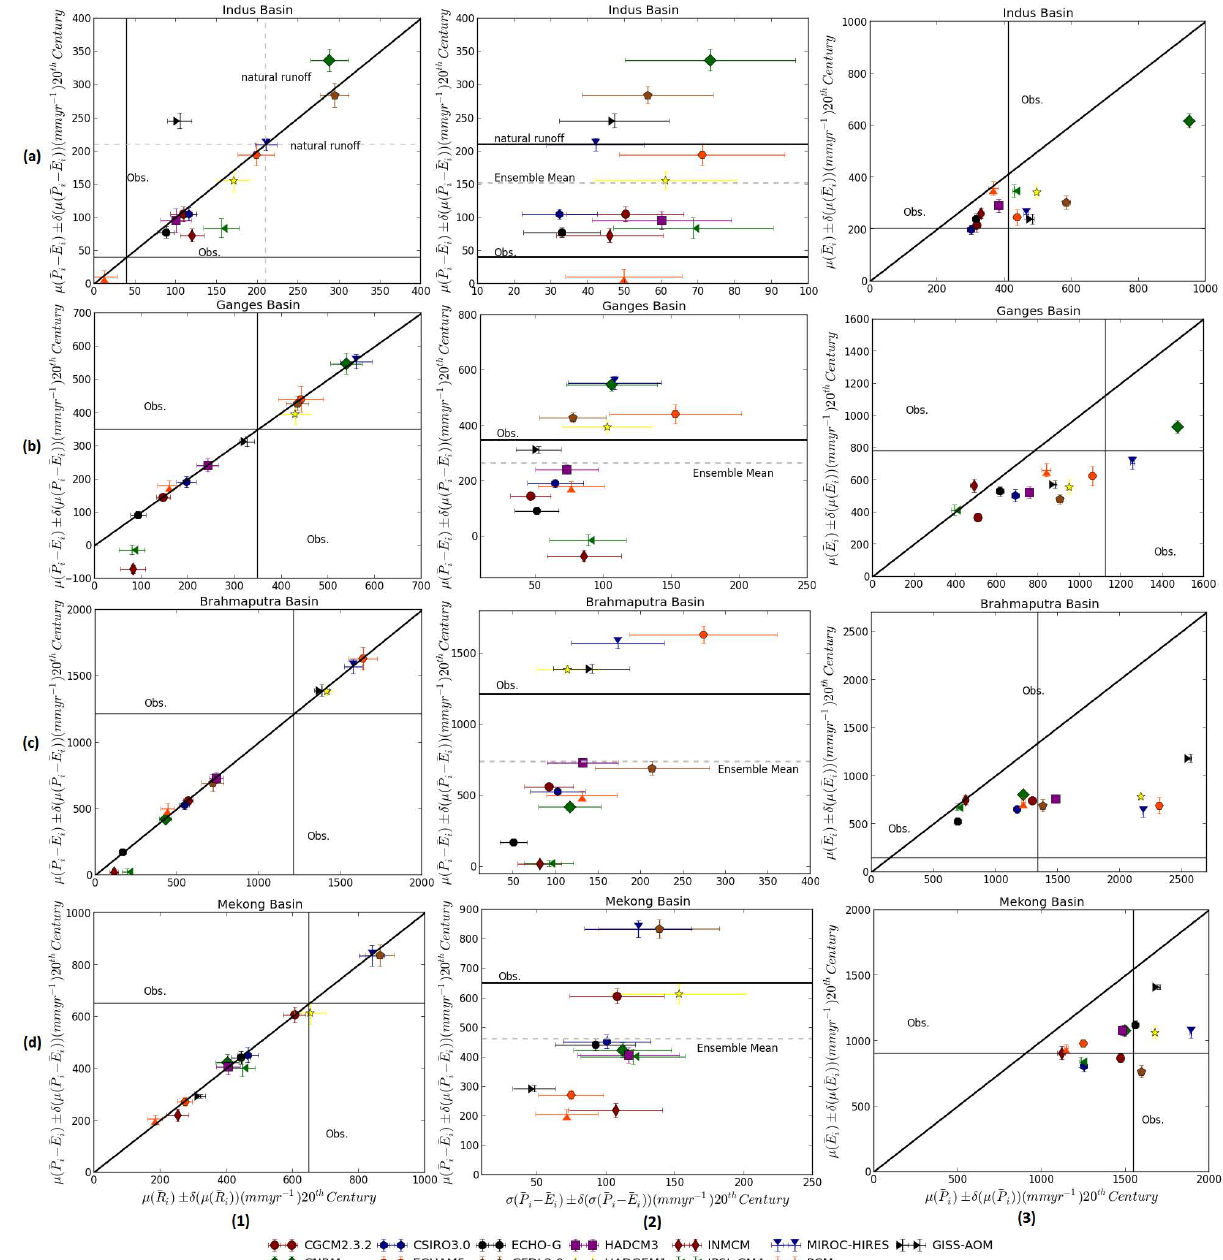
Fig. 2. (a1) – (d3) 20th century climate (1961–2000) for: (row a) Indus Basin, (row b) Ganges Basin, (row c) Brahmaputra Basin, (row d) Mekong Basin; (column 1) estimated P − E against simulated total runoff, (column 2) estimated P − E against its inter-annual variability, (column 3) E against P . Markers show mean annual simulated basin-integrated quantities, whereas lines show their 95% con- fidence intervals. (Note: for the Indus Basin both the observed runoff into the sea (influenced with irrigation and other diversions) and the estimated natural runoff (assuming no diversion within the basin) are shown – details are given in the